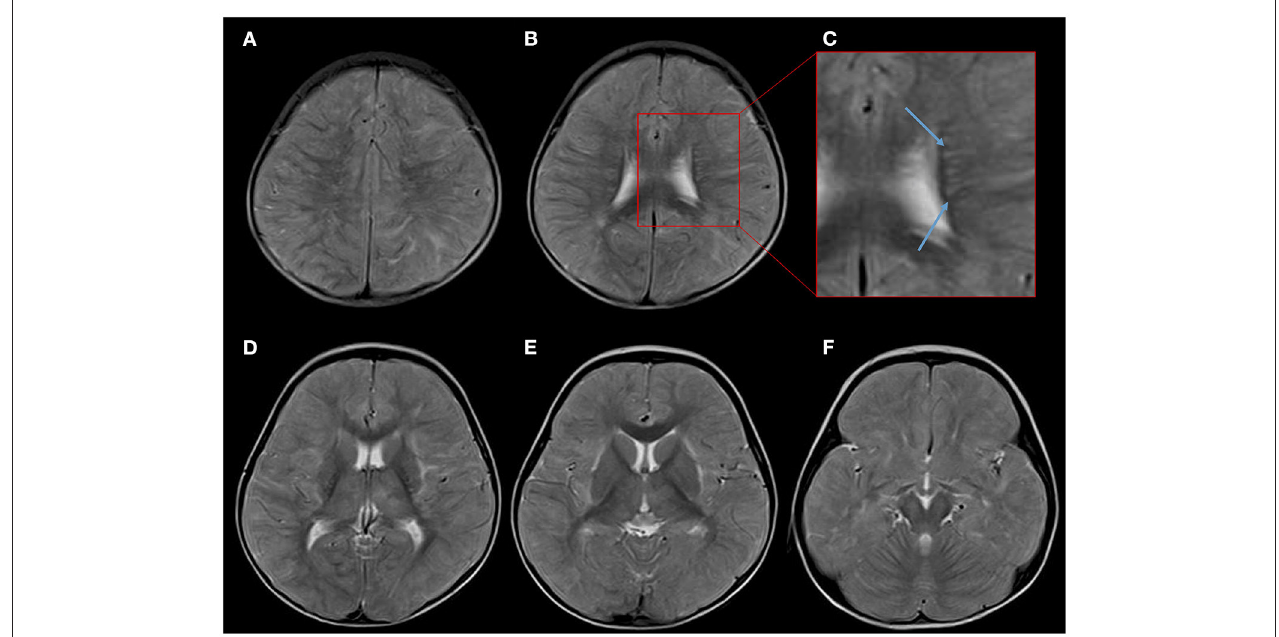
FIGURE 1 | Overview of the axial T2-weighed images (T2WI) on day 13 after the onset of Kawasaki disease. (A,B) T2WI showing scattered high-intensity lesions mainly affecting the subcortical white matter. (C) An enlarged image showing the periventricular space revealing a radial pattern of hyperintensity along the deep cerebral veins (blue arrows). (D–F) White matter lesions observed bilaterally in the subcortical white matter, thalamus, and external capsule, and sparse in the internal capsule and corpus